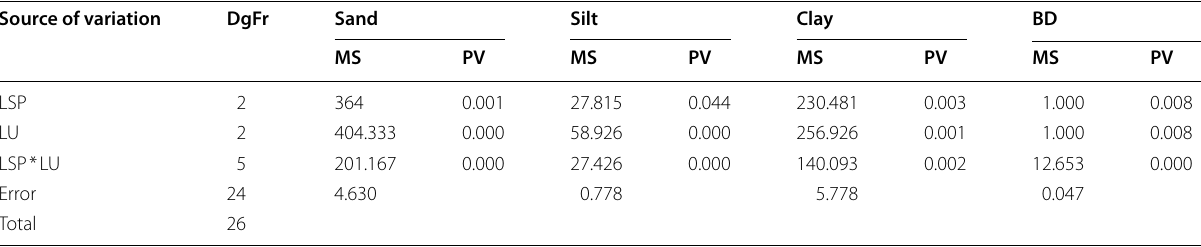
MS is the mean square, PV is the p-value, DgFr is the degree of freedom Table 2 Interaction effects of landscape positions and land use types on particle sizes distribution and bulk density (mean SE) ± Soil property